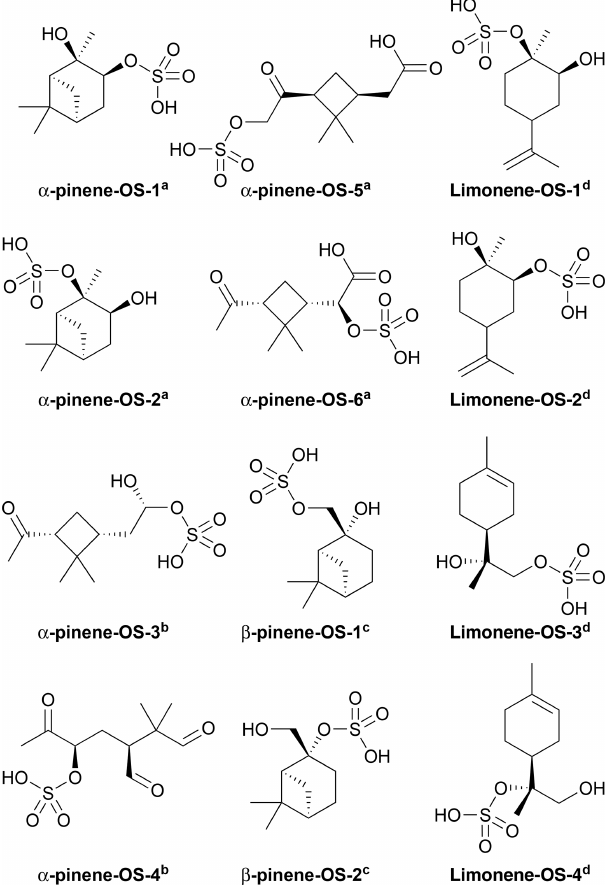
Figure 1. Structures of the studied monoterpene-derived organosul- fates, provided by a Surratt et al. (2008), b Surratt et al. (2007), c Iinuma et al. (2009) and d Hansen et al.